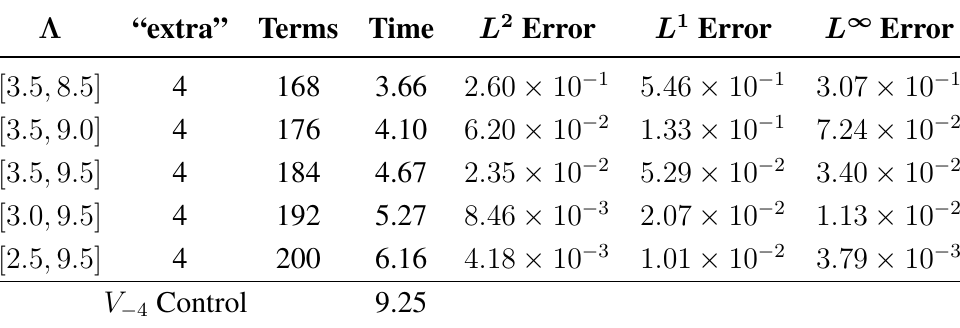
Table 3. Error from non-linear multi-scale Rossby wave results. All but the control use V − and V − 4